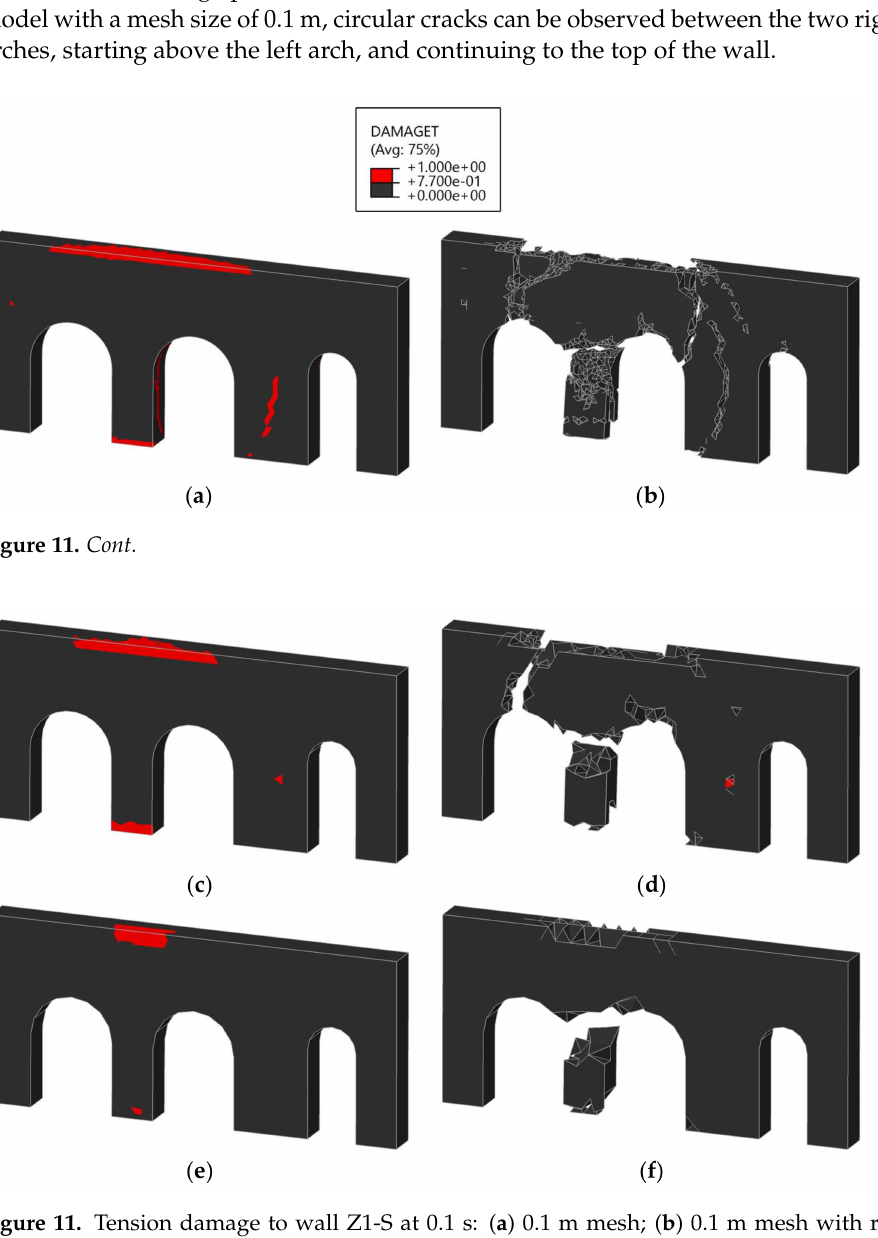
Figure 11. Tension damage to wall Z1-S at 0.1 s: ( a ) 0.1 m mesh; ( b ) 0.1 m mesh with removed damaged elements; ( c ) 0.2 m mesh; ( d ) 0.2 m mesh with removed elements; ( e ) 0.3 m mesh; ( f ) 0.3 m mesh with removed